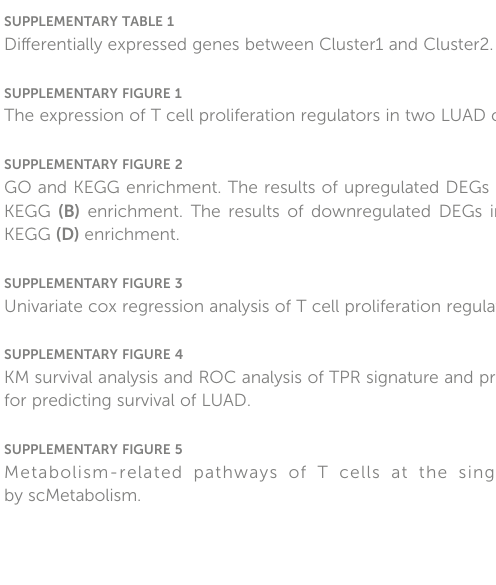
SUPPLEMENTARY TABLE 1 Differentially expressed genes between Cluster1 and Cluster2. SUPPLEMENTARY FIGURE 1 The expression of T cell proliferation regulators in two LUAD clusters. SUPPLEMENTARY FIGURE 2 GO and KEGG enrichment. The results of upregulated DEGs in GO (A) and KEGG (B) enrichment. The results of downregulated DEGs in GO (C) and KEGG (D) enrichment. SUPPLEMENTARY FIGURE 3 Univariate cox regression analysis of T cell proliferation regulators. SUPPLEMENTARY FIGURE 4 KM survival analysis and ROC analysis of TPR signature and previous studies for predicting survival of LUAD. SUPPLEMENTARY FIGURE 5 Metabolism-related pathways of T cells at the single-cell level by